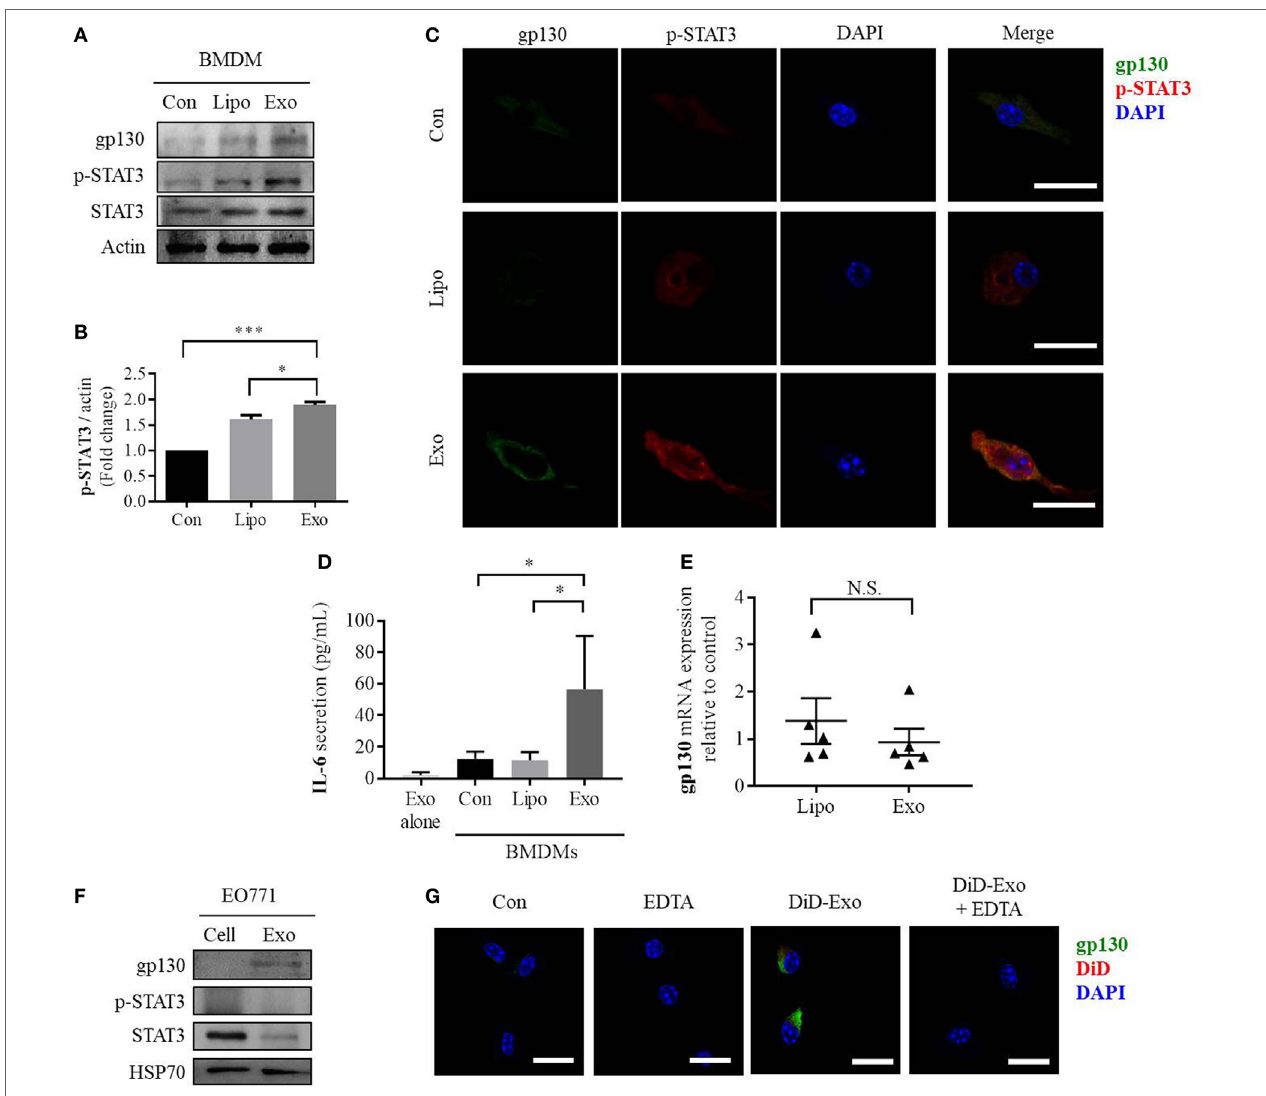
FigUre 2 | EO771-derived exosomes increase gp130 and p-STAT3 in recipient bone marrow-derived macrophages (BMDMs). (a) Macrophages were treated for 24 h with PBS alone (Con), liposomes (Lipo), or EO771-derived exosomes (Exo). Cell lysates were evaluated for gp130, p-STAT3, and STAT3 protein expression. Actin served as loading control. (B) Densitometry analysis of p-STAT3 levels as normalized by actin. (c) gp130 and p-STAT3 expression assessment after exposure of macrophages to PBS, liposomes, or EO771-derived exosomes for 24 h by immunofluorescence microscopy. The images were captured at 100 × magnification and the size bar represents 20 µm. Nuclei of macrophages were visualized with DAPI. (D) Interleukin-6 (IL-6) secretion by macrophages after treatment with PBS, liposomes, or EO771-derived exosomes for 24 h was assessed by ELISA ( n = 4). * p < 0.05 as indicated. As control, IL-6 protein content in exosomes is shown in the left column. (e) gp130 mRNA expression by macrophages after treatment with liposomes or EO771-derived exosomes for 24 h was assessed by qRT-PCR. Relative gene expression levels were normalized to GAPDH and results are shown as relative to PBS-treated BMDMs ( n = 3). N.S., not statistically significant. (F) gp130, p-STAT3, and STAT3 protein expression in EO771 cell lysate (Cell) and exosomes (Exo). HSP70 is used as loading control. (g) Macrophages were pre-exposed to EDTA (EDTA) or PBS alone (Con) for an hour before treatment with DiD-labeled, EO771-derived exosomes for 24 h (DiD-Exo + EDTA and DiD-exo, respectively). DiD signal and gp130 localization were visualized by fluorescence microscopy. The size bar represents 20